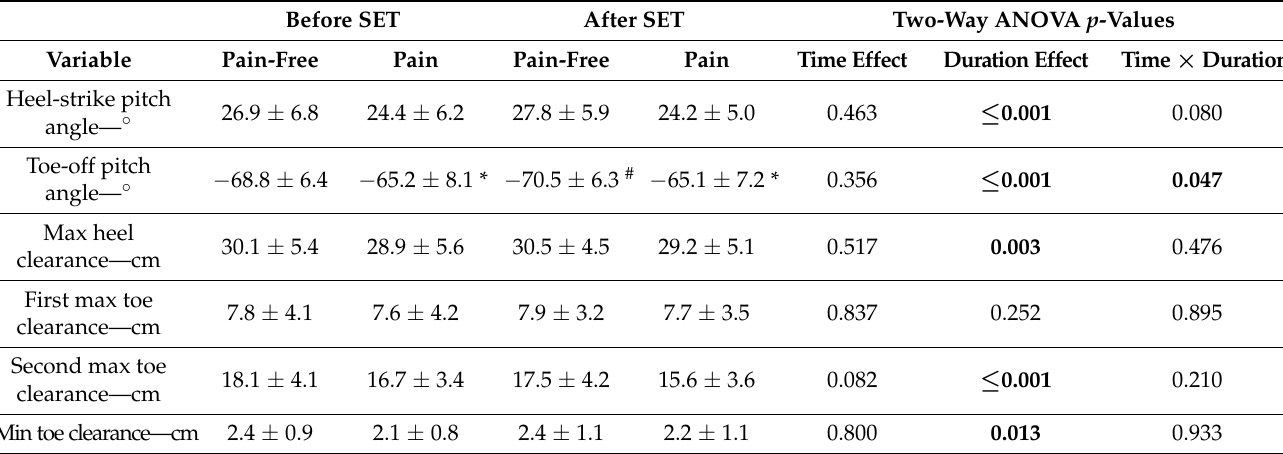
Table 4. Foot kinematics in the most symptomatic leg during the 6 min walk test before and after supervised exercise training (SET).